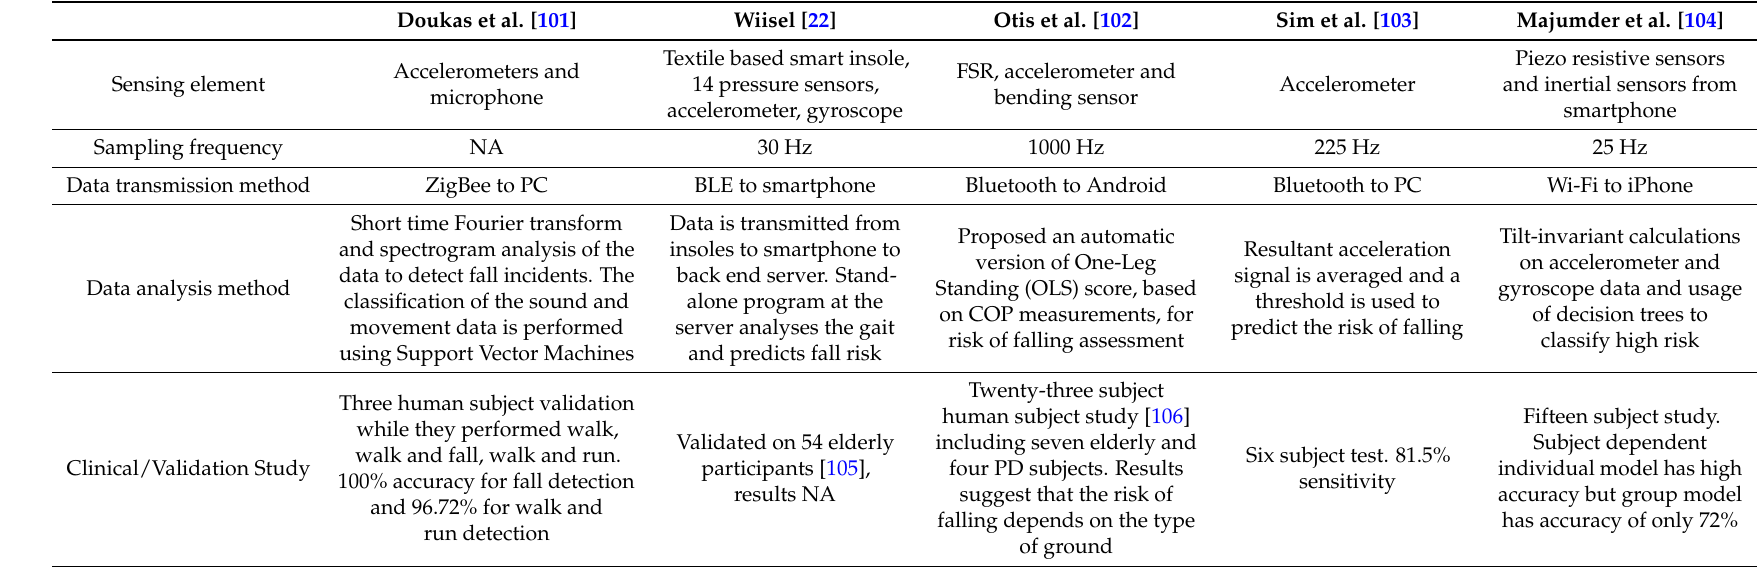
Table 5. Comparison of footwear-based systems in fall risk